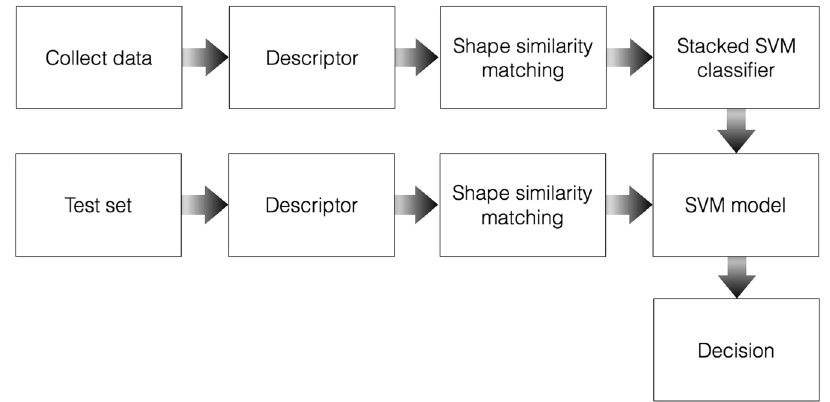
Figure 1. Block diagram of the algorithm.